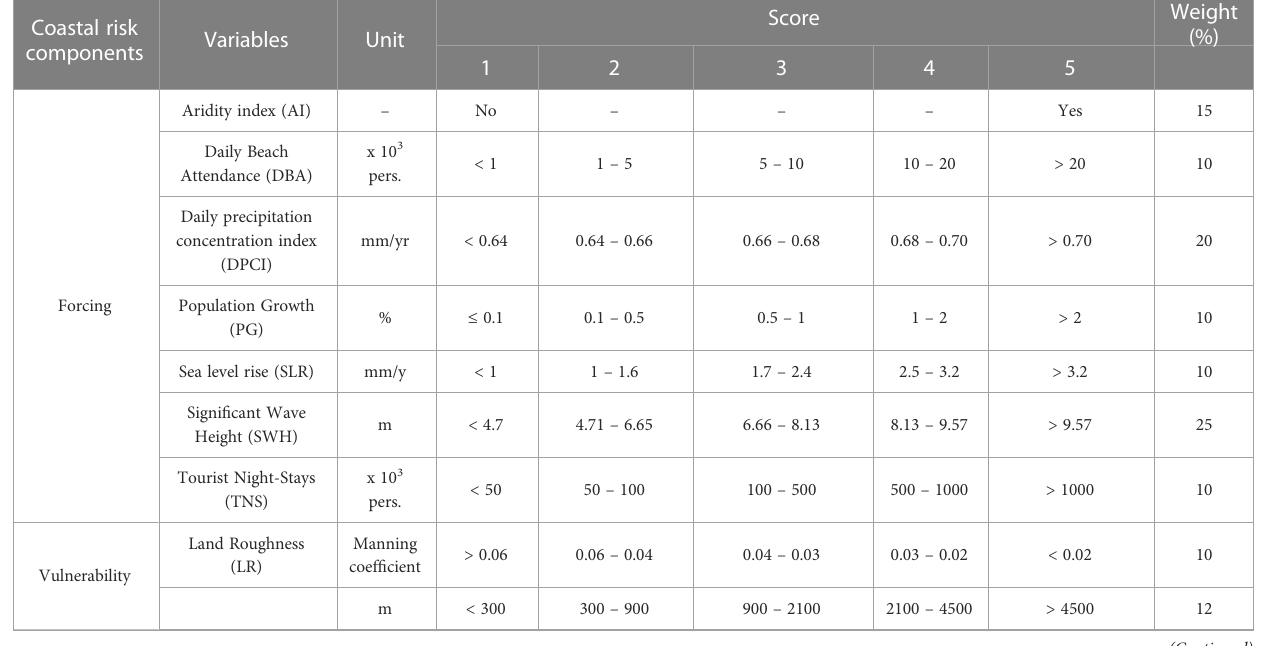
TABLE 3 Variable selection and ranking for the CRI-LS